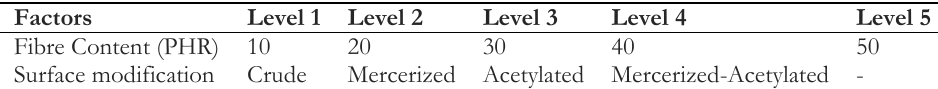
Table 1. Factors and level selection for composite formulation.